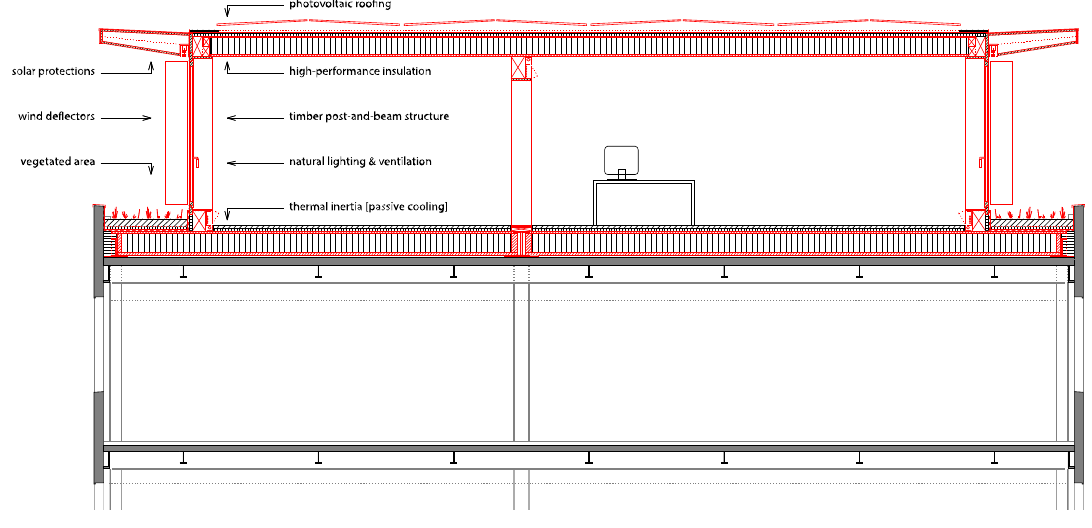
Figure 4. Cross section through the system’s envelope showing its bioclimatic principles. Elements in red refer to the new construction, while elements in black refer to the existing building.